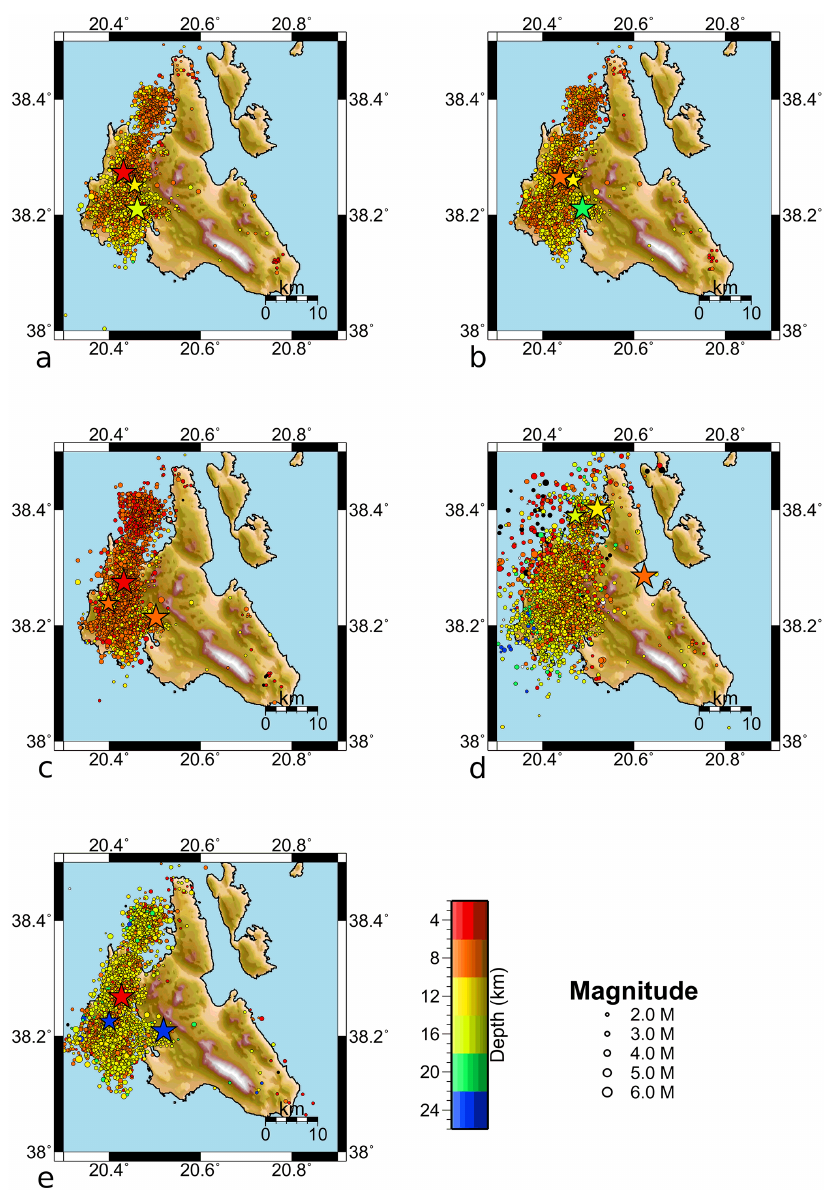
Figure 7. Relocation results by using the velocity models of (a) the 2-D velocity model that resembles the Moho structure, (b) the 1-D velocity model proposed by Haslinger et al. (1999), (c) the 1-D velocity model proposed by Sachpazi et al. (2000), (d) the 1-D velocity model proposed by Hirn et al. (1996), and (e) the 1-D velocity model used by NOAGI for the daily seismic monitoring.